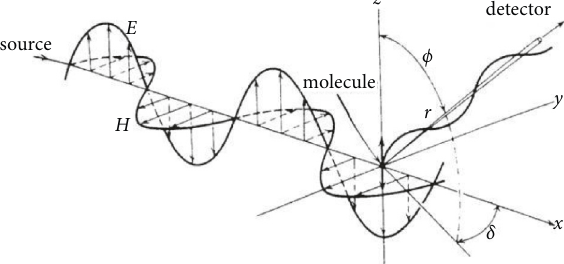
Figure 1: Molecular scattering of flat polarised light. Dipole 2d in the direction of the z -axis for isotropic induction